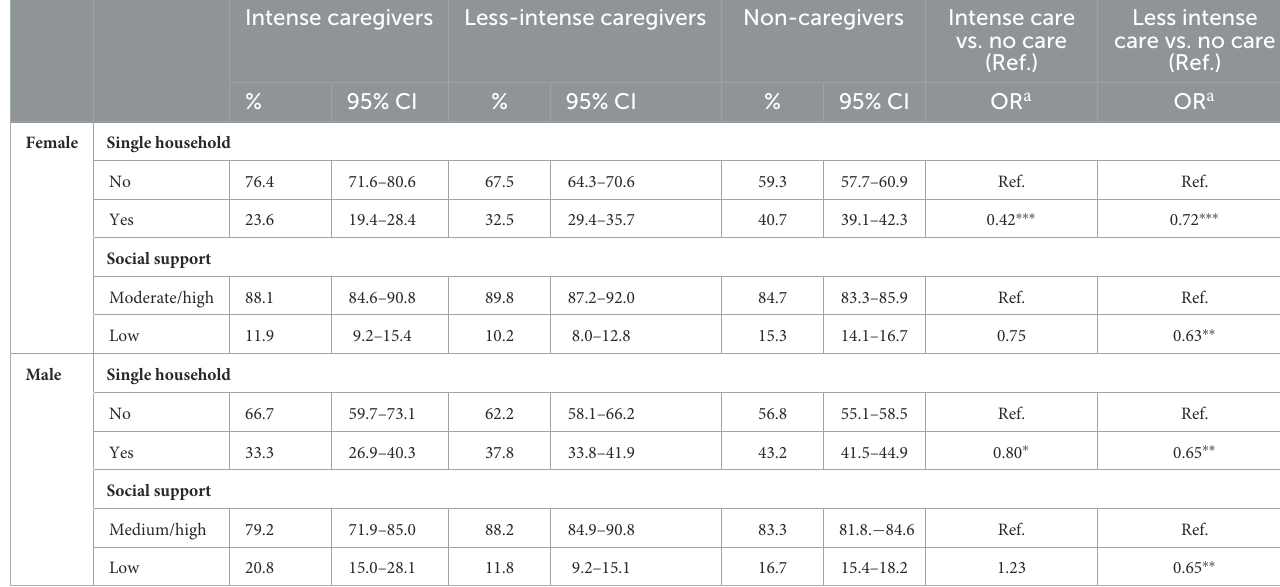
Less intense vs. no care care vs. no care (Ref.) (Ref.) OR